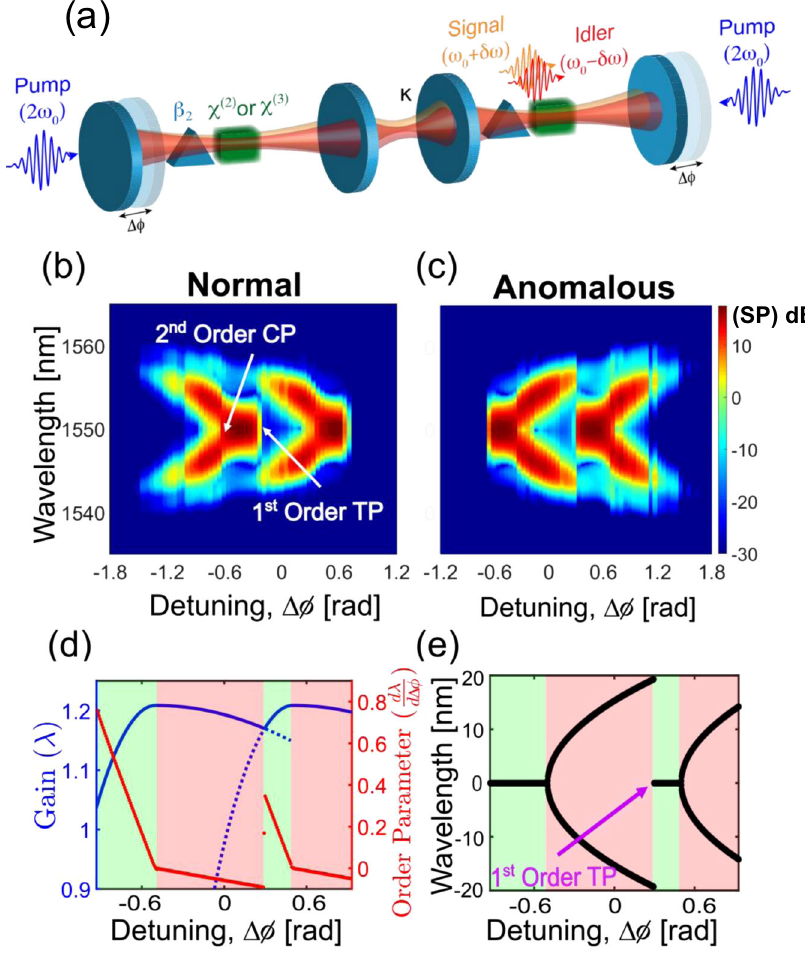
Fig. 4 First-order spectral phase transition in coupled OPOs. a Schematic con fi guration of a coupled OPO (coupling factor ( κ )). Simulated spectrum (SP) as a function of the cavity detuning b in the normal dispersion regime, c in the anomalous dispersion regime. d Order parameter as a function of detuning showing the discontinuity at the location of the fi rst-order transition point. The gain curve is also plotted alongside. The OPO selects the gain maximum and therefore doesn't follow the dashed portion of the gain curve. This gain competition between two second-order critical point gives rise to the fi rst-order transition point. e The spectrum considering the wavelength experiencing the maximum gain around which the signal/idler is centered. At the fi rst-order transition, there is a discontinuous jump from the non-degenerate spectrum to the degenerate